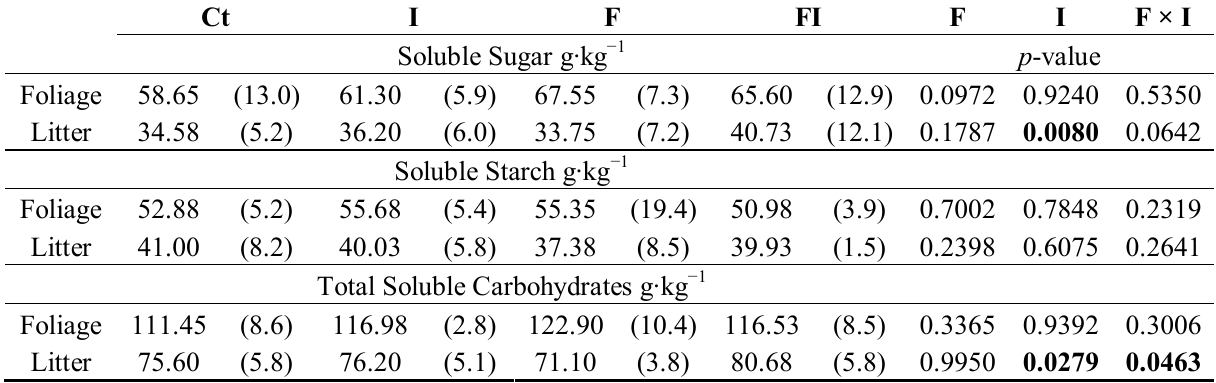
Table 3. Mean loblolly pine soluble carbohydrate fraction concentrations in control